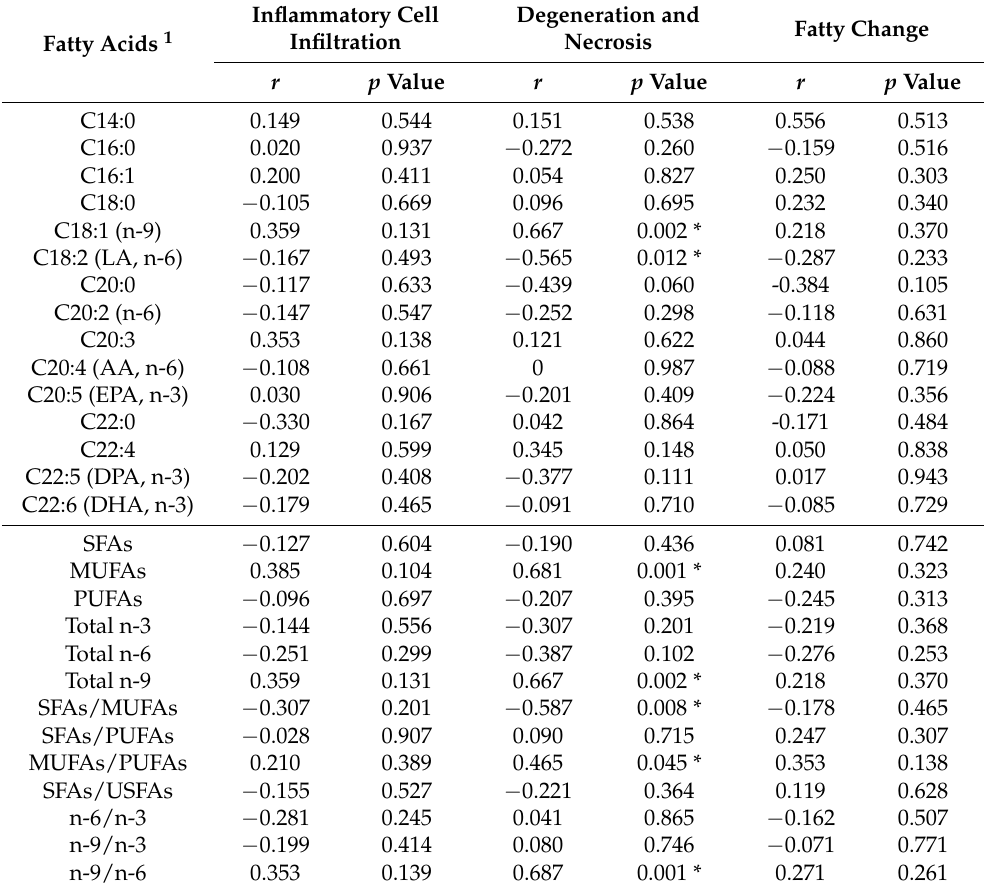
Table 12. The correlation of erythrocytic fatty acid composition and hepatic histopathological analysis scores in rats. Inflammatory Cell Degeneration and Infiltration Fatty Acids 1